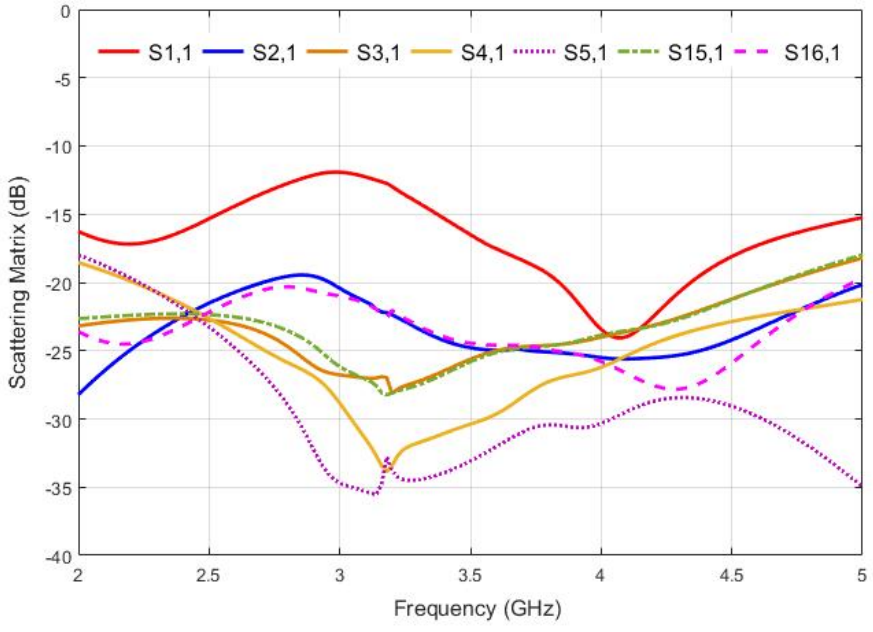
Figure 10. Scattering matrix of 16 PLPA elements: S1,1-S2,1-S3,1-S4,1-S5,1-S15,1-S16,1. In the proposed MIS, there are 16 antennas, one of which acts as a transmitter, while the remaining 15 antennas act as receivers to collect scattered signals from the phantom. The entire process is repeated for all antennas, resulting in 240 (16 × 15) scanned data points from the breast phantom. The collected backscattered signals are then analyzed using DAS algorithm with a suitable computing system to determine the presence of tumor. A picture of the imaging result can be seen in Figure 11 for two different locations of tumor in breast phantom. The ranges for x, y, and z are measured in meters. The 3D phantom is in hemispherical shape. As we move along the z axis the radius of the circular slice starts decreasing till it reaches the apex point. The results are obtained at different horizontal planes as slices along the z axis. The Figure 11 shows 2D images at z = 0.005 m and z = 0.02 m positions (i.e., a slice of image at z location of 5 mm and 20 mm). Therefore, if the tumor is located along the z axis it will be detected and shown in the horizontal slices at that z-location. As can be seen, the proposed system successfully detects the presence of tumor with a dark red color. A comparison of different MIS in literature with the proposed one is presented in Table 1. In this regard, the system designed proves to be a good method for detecting breast cancer using microwave